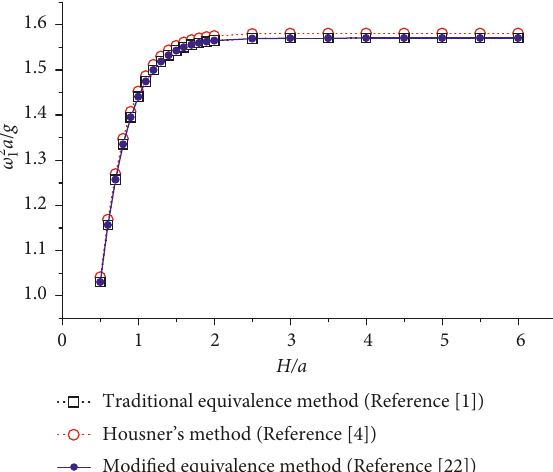
Figure 4: Position ratio h (rectangular